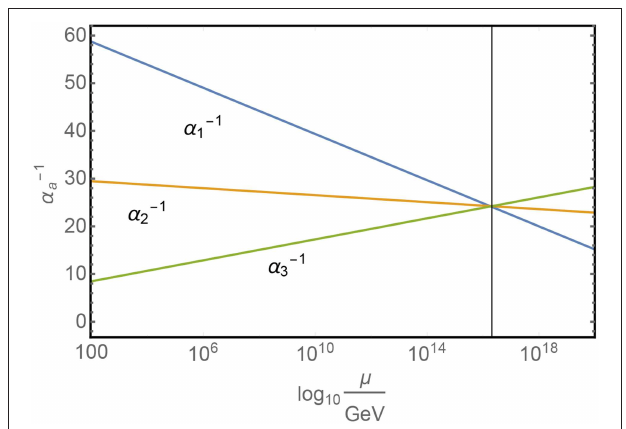
FIGURE 2 | Renormalization Group flow of the MSSM gauge